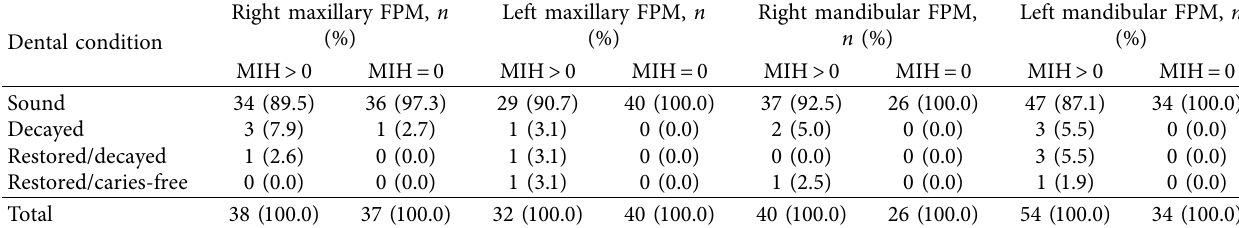
Table 4: Frequency of frst permanent molars (FPM) afected or not by MIH, according to caries experience. Dental condition